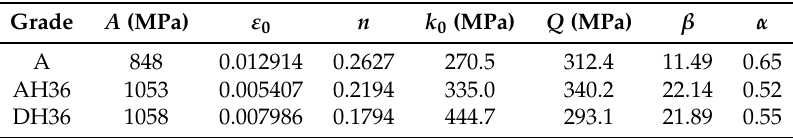
Table 2. Identified hardening law